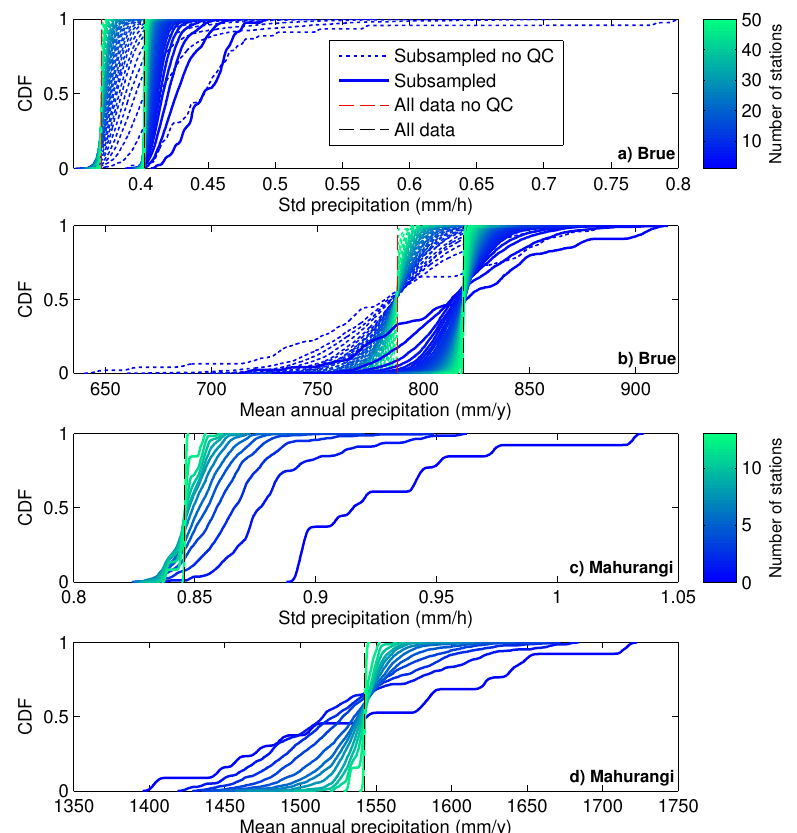
Figure 5. ( a and c ) standard deviation of hourly precipitation and, ( b and d ) mean annual precipitation for different numbers of subsampled stations. For Mahurangi, results are shown for the period without missing discharge values. Point measurement uncertainty was included and we used 4000 Monte Carlo